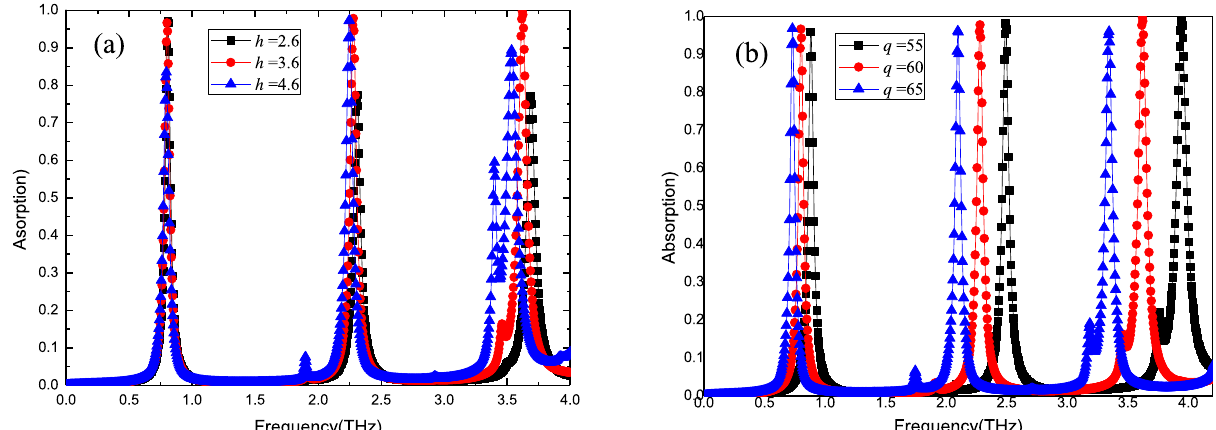
Fig. 7. The in fl uence of structural parameters on the absorption. (a) Change dielectric thickness h , (b) change circular patch diameter q , where other parameters